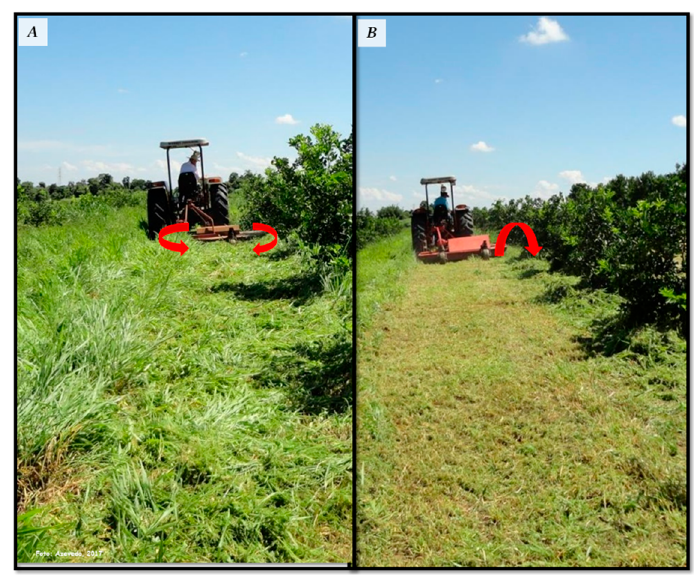
Figure 1. Conventional mower (CONV) ( A ) and Ecological mower (ECO) ( B ) .